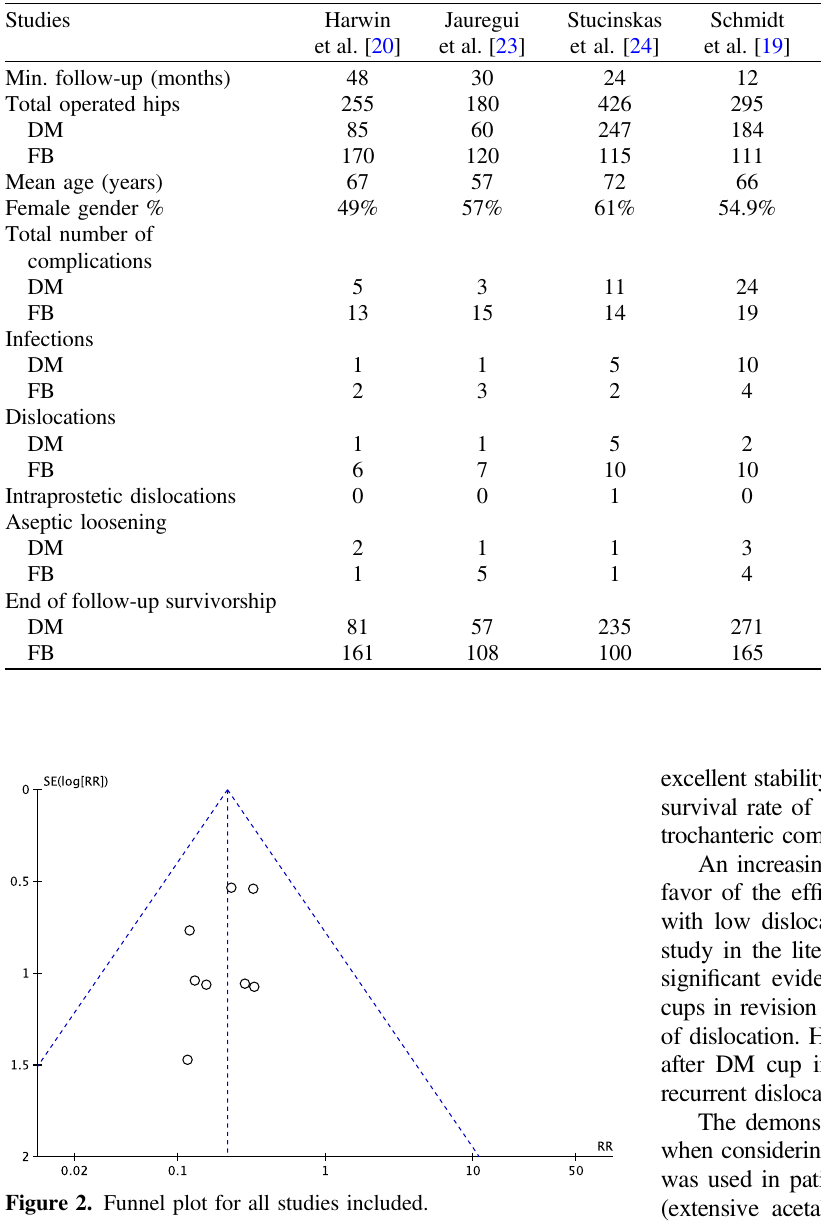
Table 2. Details of included studies.